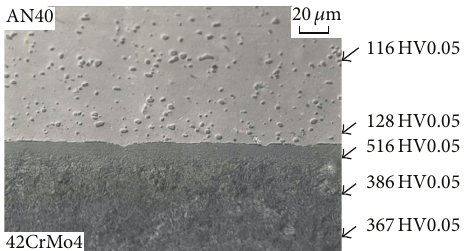
Figure 21: The microstructure of the friction welded AN40 alloy-42CrMo4 steel joint.